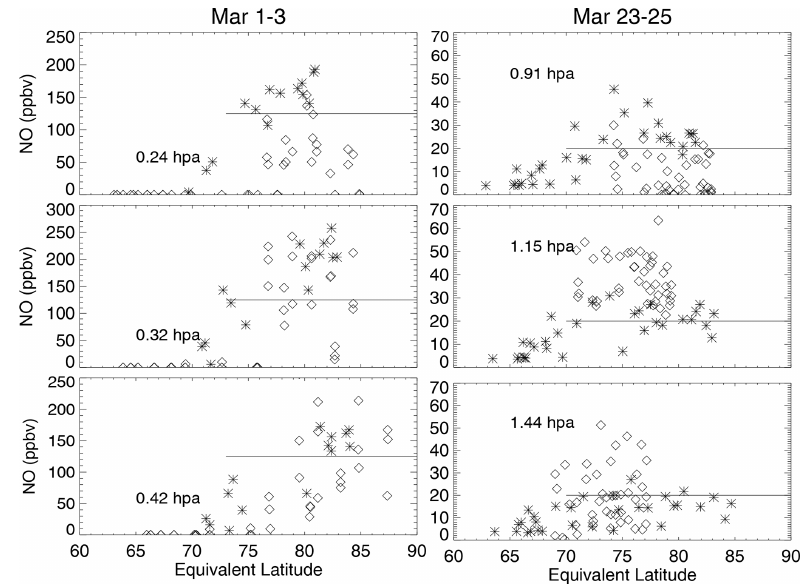
Figure 13. ACE (stars) and SOFIE (diamonds) NO data plotted vs. equivalent latitude for the three pressures near the center of the layer as seen in Fig. 8. The geographic latitude coverage is given in Fig. 8. The horizontal lines in each panel are arbitrary constant values of NO used in a geometric estimate of the global amount of NO that might be consistent with the observations.